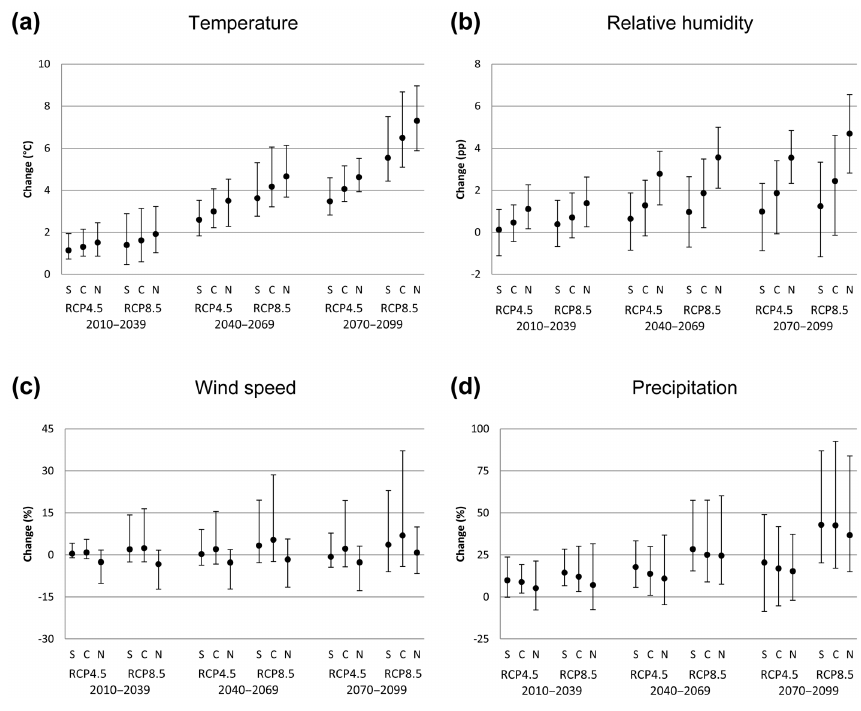
Figure 2. Projected changes in November–March mean 2m air temperature (a) , mean 2m relative humidity (b) , mean 10m wind speed (c) and total precipitation (d) compared to the period 1980–2009 and averaged over southern (S), central (C) and northern (N) Finland. Dots indicate the multi-model mean change and whiskers extend to the maximum and minimum projections.